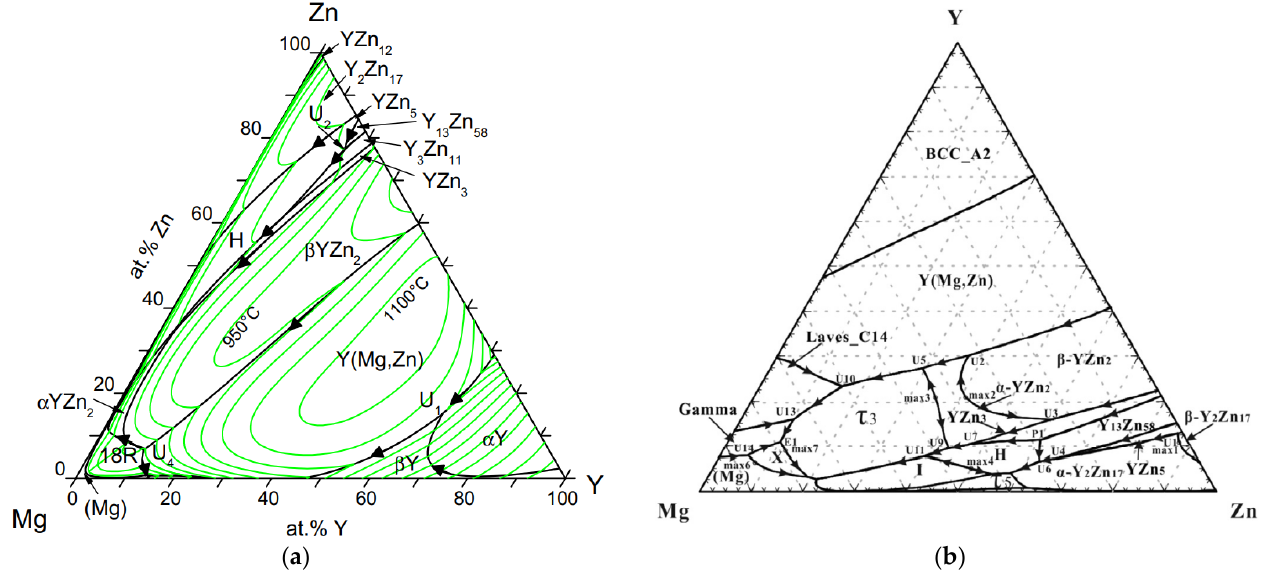
Figure 7. Liquidus projections of the ternary Mg-Zn-Y phase diagram; ( a ) Gröbner et al . [121] and ( b ) Zhu and Pelton [141].